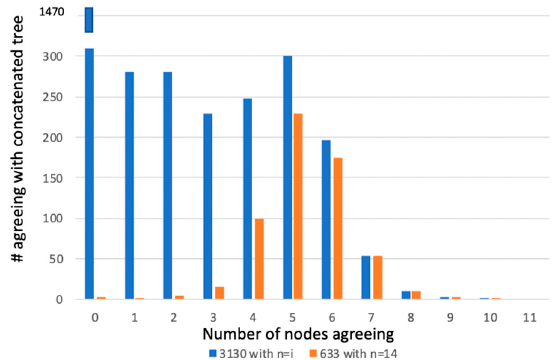
Figure 3. Plot of number of proteins in two different datasets on the Y axis versus the number of nodes in agreement with the concatenated tree. The blue bars represent the dataset with all 3130 proteins, regardless of taxonomic coverage. The orange bars represent the dataset with proteins across all 14 taxa. A 50% bootstrap cutoff was used to say that a node existed for a particular gene partition. See reference [89].